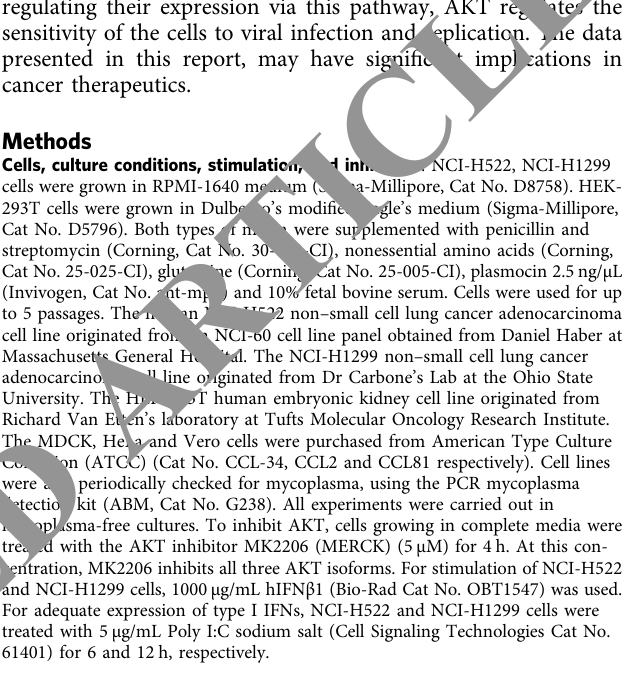
Table 2. All the constructs were sequenced in the Genomics Shared Resource (GSR) of OSUCCC. https://cancer.osu.edu/for-cancer-researchers/resources-for-cancer- researchers/shared-resources/genomics, prior to